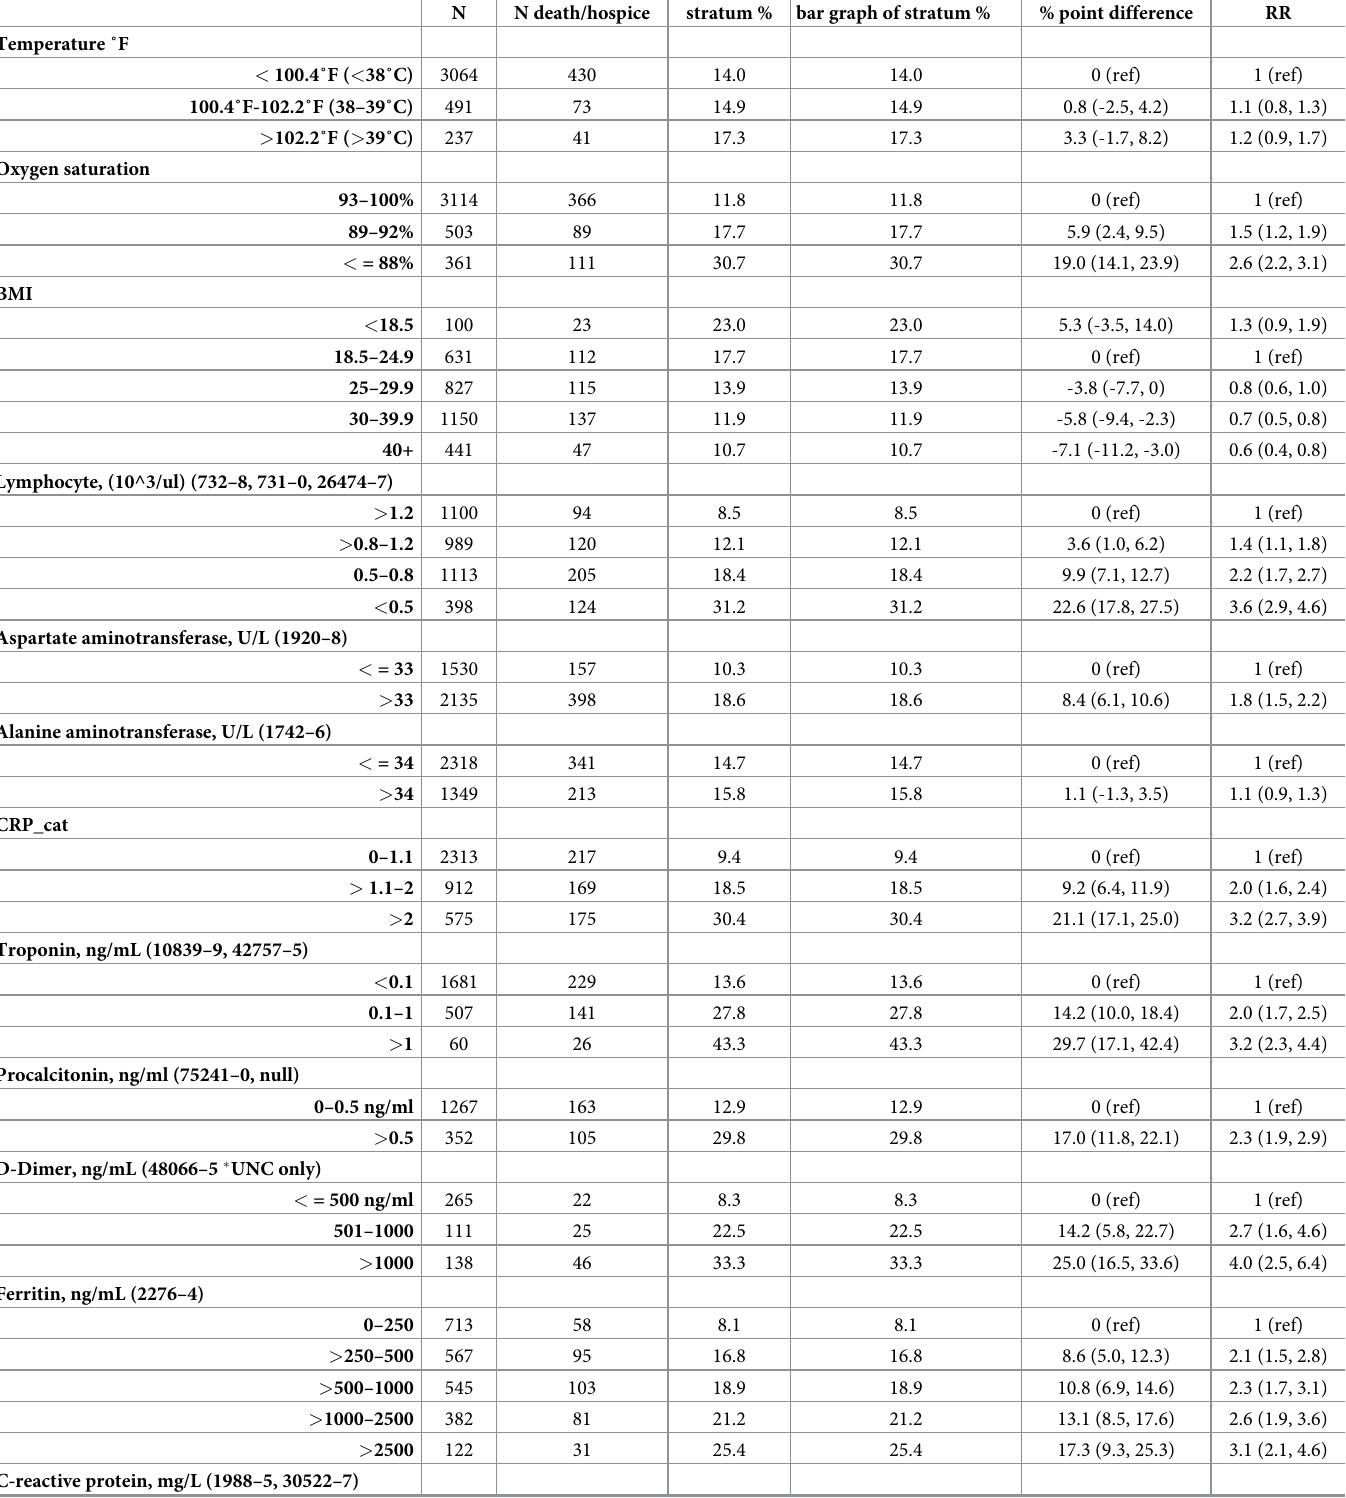
Table 4. Initial vitals and labs and percentage of death/hospice discharge for patients hospitalized with a SARS-CoV-2 infection or COVID-19 diagnosis. N N death/hospice stratum % bar graph of stratum % % point difference RR Temperature ˚F < 100.4˚F ( < 38˚C)